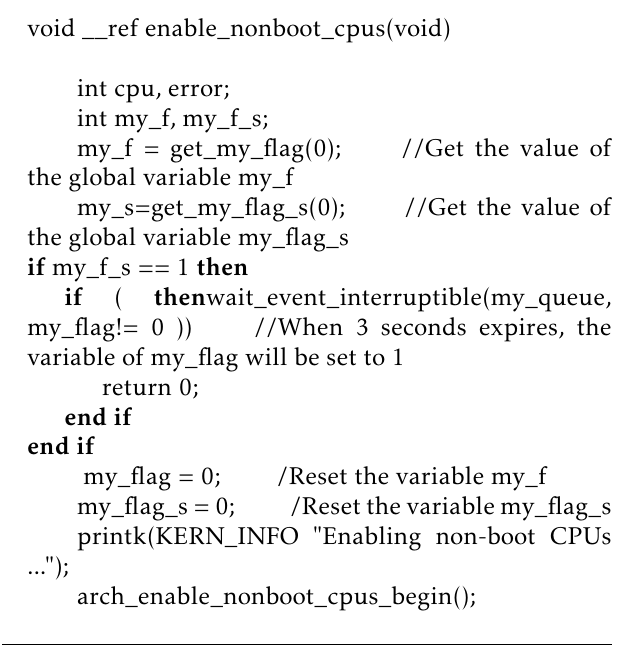
Algorithm 2 /kernel/net/core/dev.c